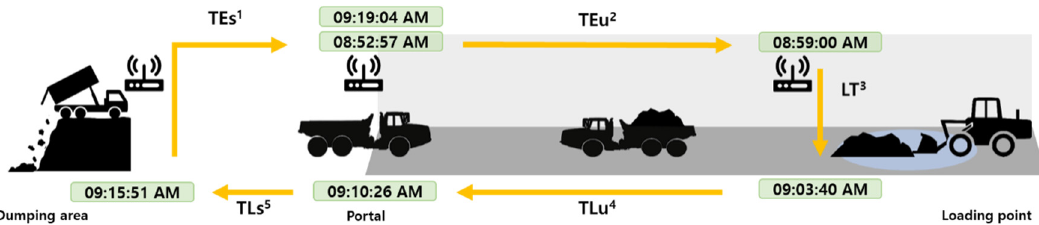
Figure 4. An illustration of the process of classifying the truck tag recognition packet data and measuring the five types of truck travel time: TEs 1 —empty truck surface travel time; TEu 2 —empty truck underground travel time; LT 3 —loading time; TLu 4 —loaded truck underground travel time; TLs 5 —loaded truck surface travel time.